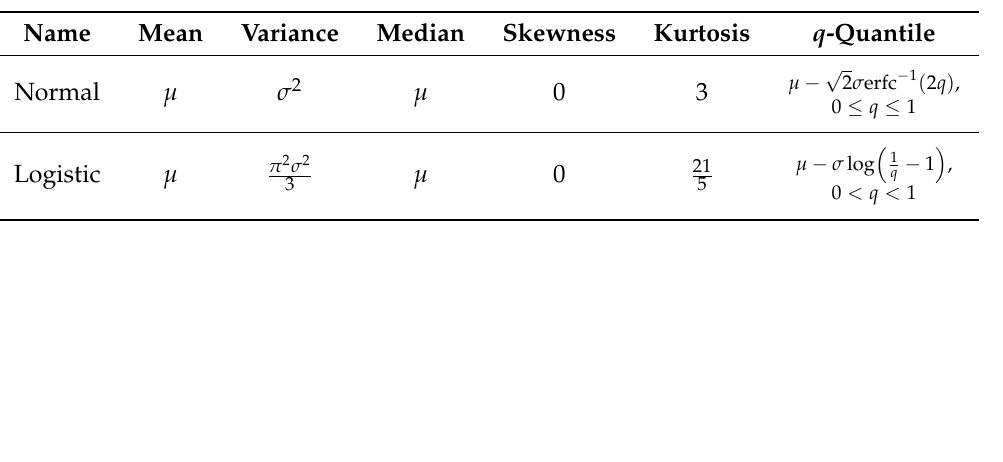
Table 1. Features for the two compared continuous